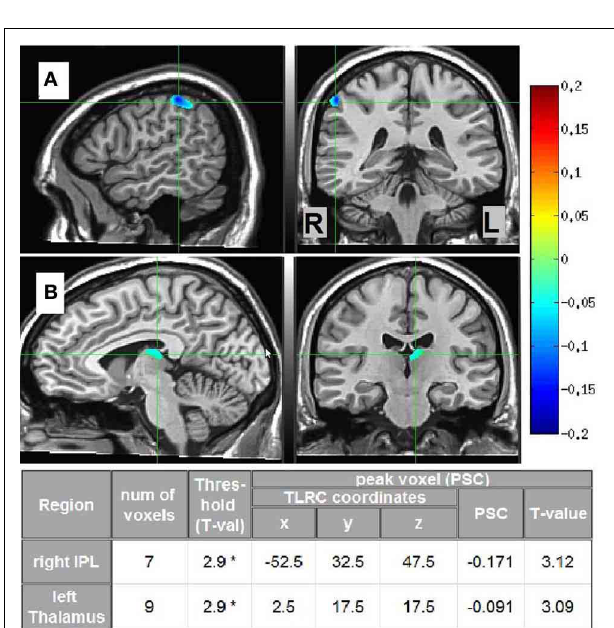
FIGURE 7 | LO source estimates. Sagittal and coronal views of significant ( ∗ p < 0 . 02, corrected) LO source estimates ( n = 4) relative to the other participants ( n = 6, not including “unclear” category), overlayed on the Colin template. Crosshairs are in (A) on the right IPL; and in (B) on the left dorsomedial thalamus. The table provides Talairach coordinates, PSC, and other cluster